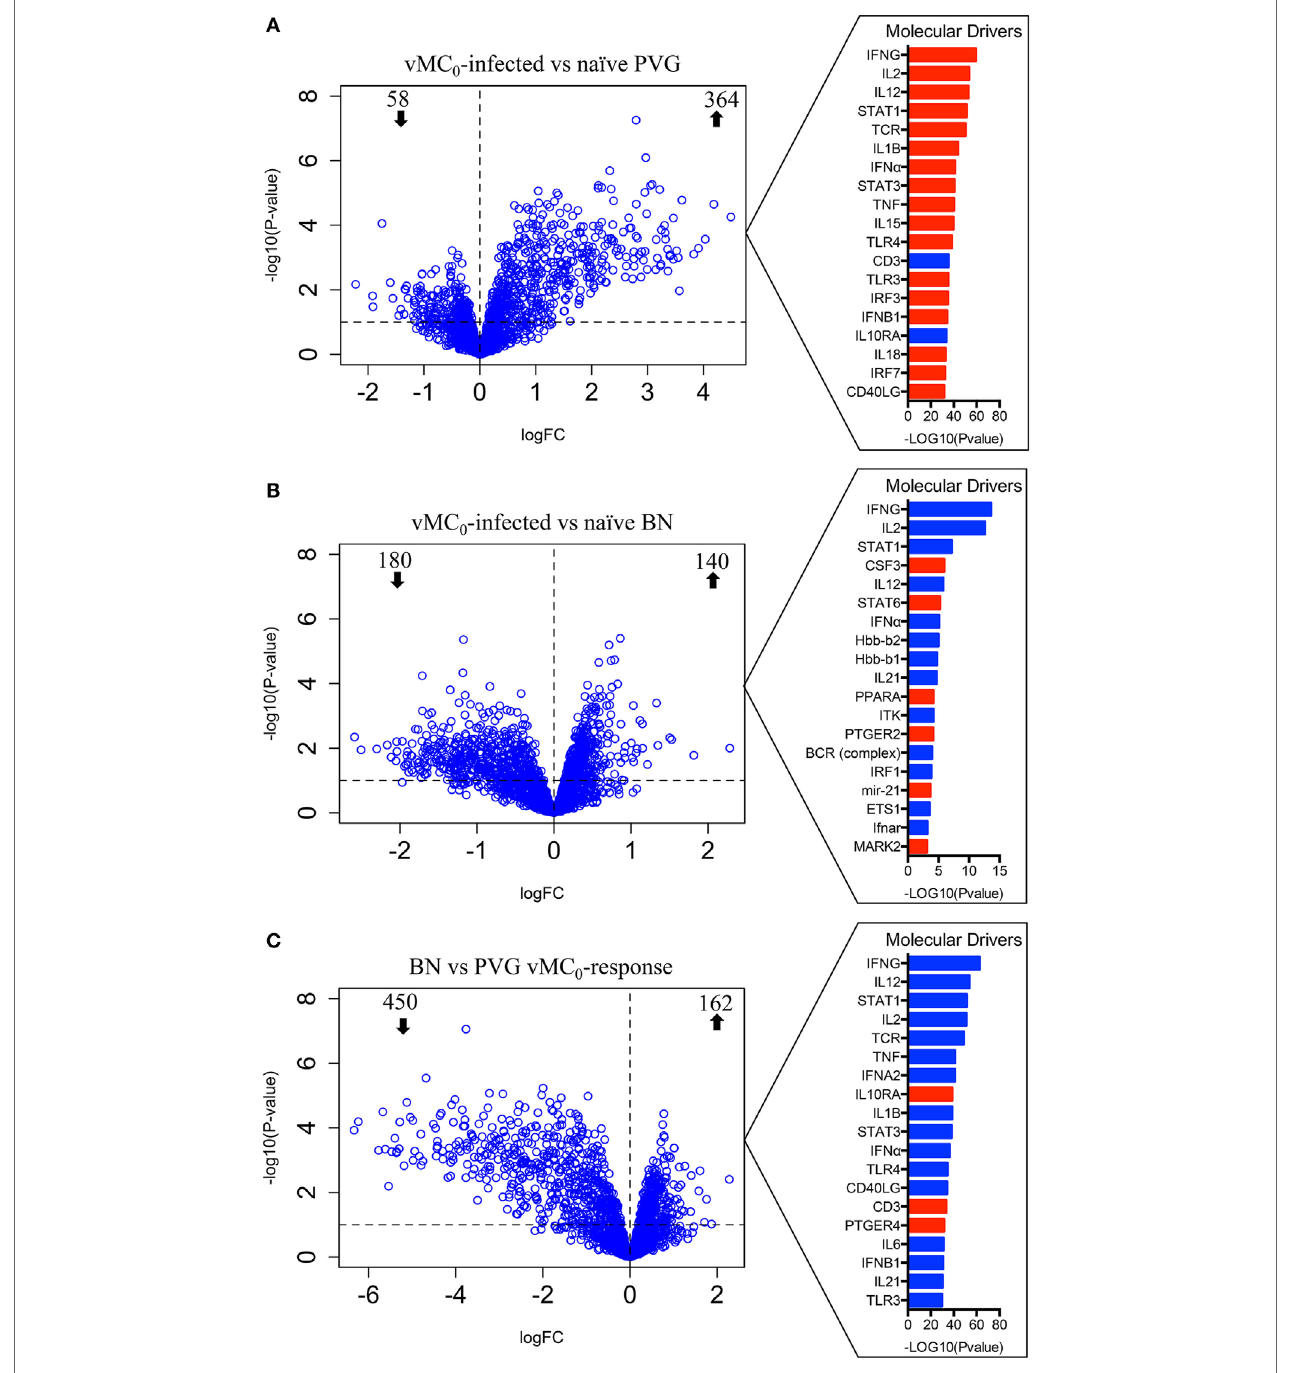
FigUre 2 | vMC 0 infection induces an antiviral response in Th2 low PVG, but not in the Th2 high BN. Bronchoalveolar lavage (BAL) cells were collected in PVG and BN at day 1 post-infection. Left panel: differentially expressed genes of BAL cells were identified comparing (a) naïve versus vMC 0 -infected PVG rats, (B) naïve versus vMC 0 -infected BN rats, and (c) BN versus PVG responses to vMC 0 . The dashed horizontal lines indicate an adjusted p -value < 0.1; n = 3. Right panel: top molecular drivers were identified with the Ingenuity Knowledge Base. Drivers in red denote activation and blue indicates inhibition. Absolute activation Z -scores ≥ 2.0 and p -values < 0.01 were deemed significant.